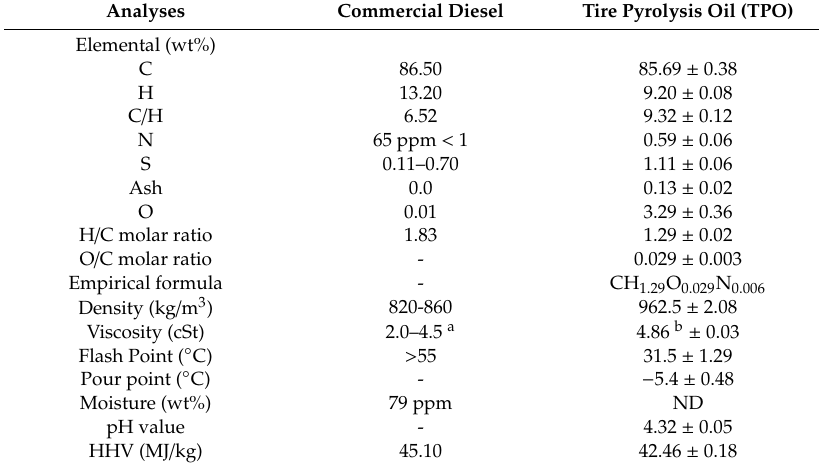
Table 4. Characteristics of the tire pyrolysis oil (TPO) in comparison to commercial diesel.